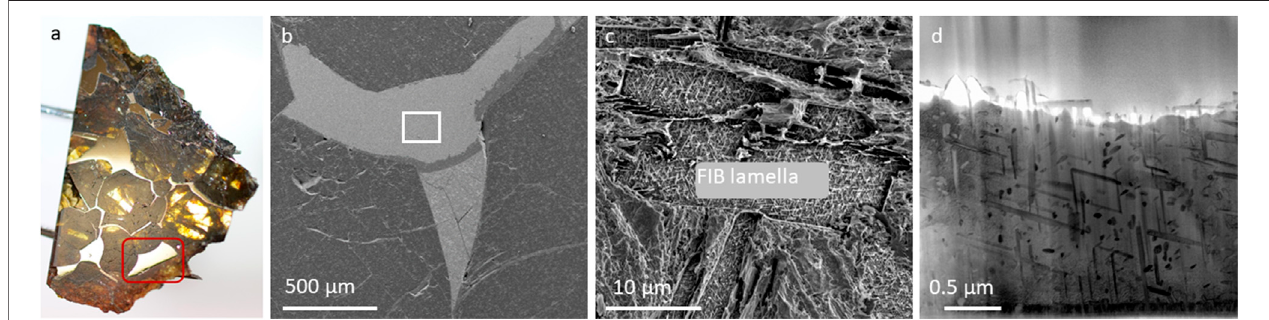
Frontiers in Astronomy and Space Sciences |